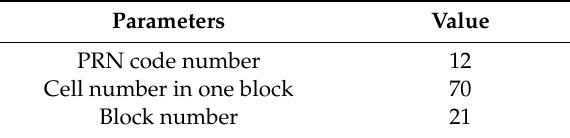
Table 3. New search space